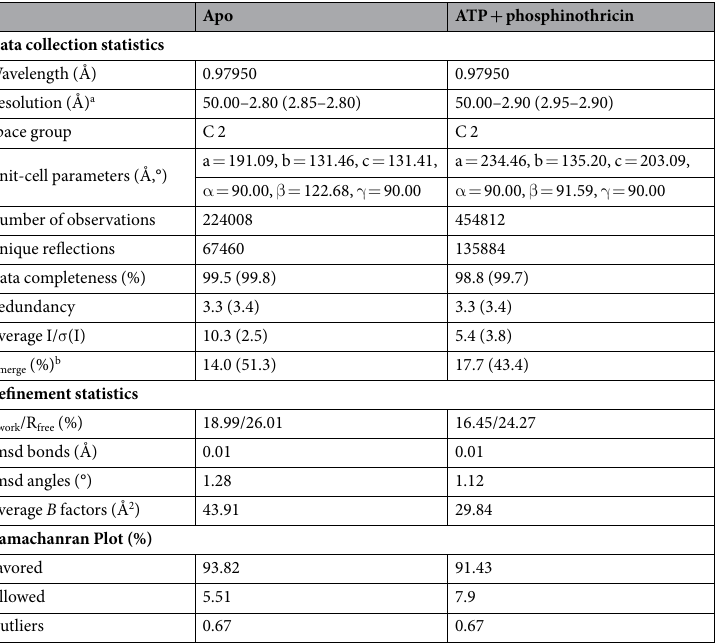
Table 1. Data collection and refinement statistics. a Numbers in parentheses reflect the highest